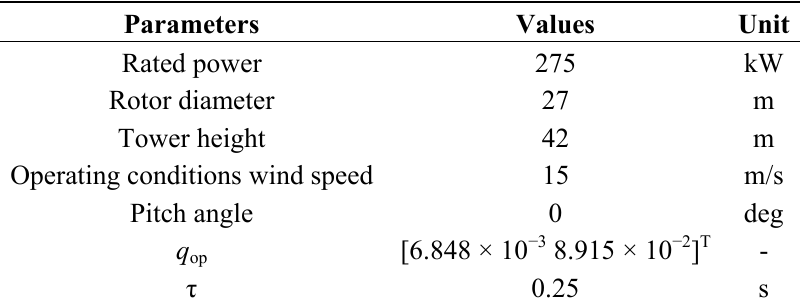
Table 2. Wind turbine parameters